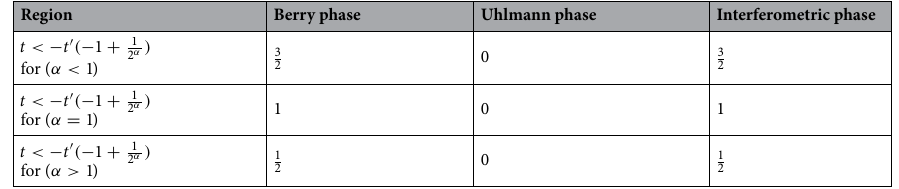
1 t 1 ) for k π . The blue curve represents the zero temperature ′ ( − 2 α = − + = 0.1 respectively. =